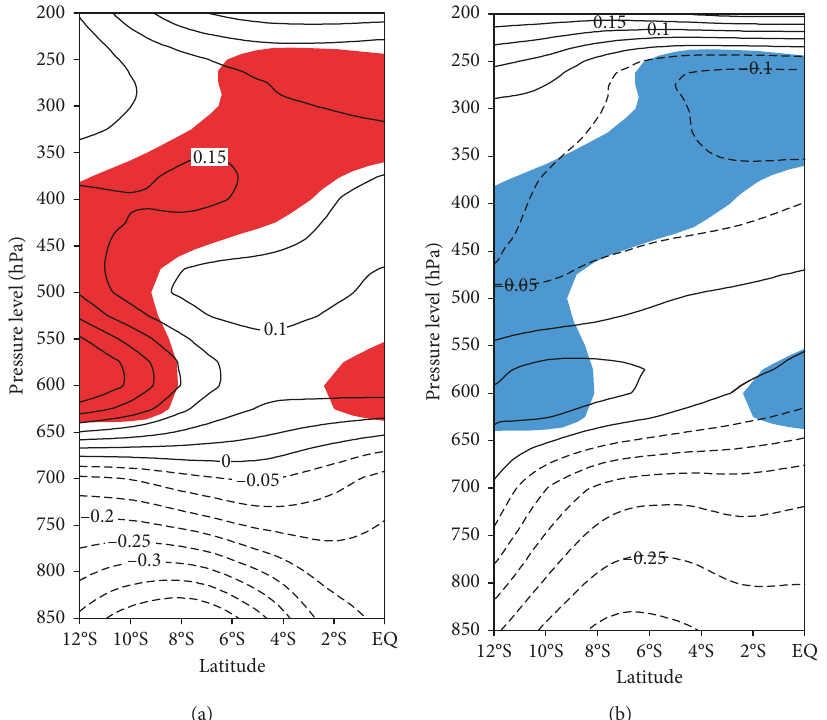
Figure 9: Composite vertical cross section of temperature anomalies along 28 ° E during (a) anomalous and (b) suppressed periods of HREs based on 1980–2010 climatology. Shading indicates significant areas at 95% confidence